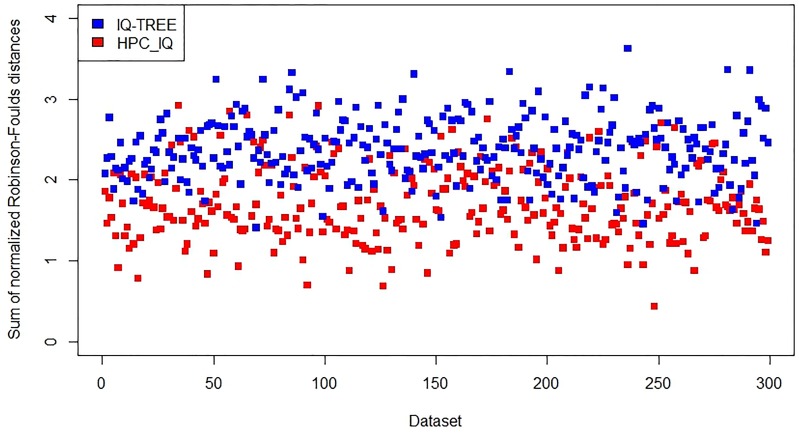
Accuracy assessment of IQ-TREE and HPCIQ on 300 Wide datasets.